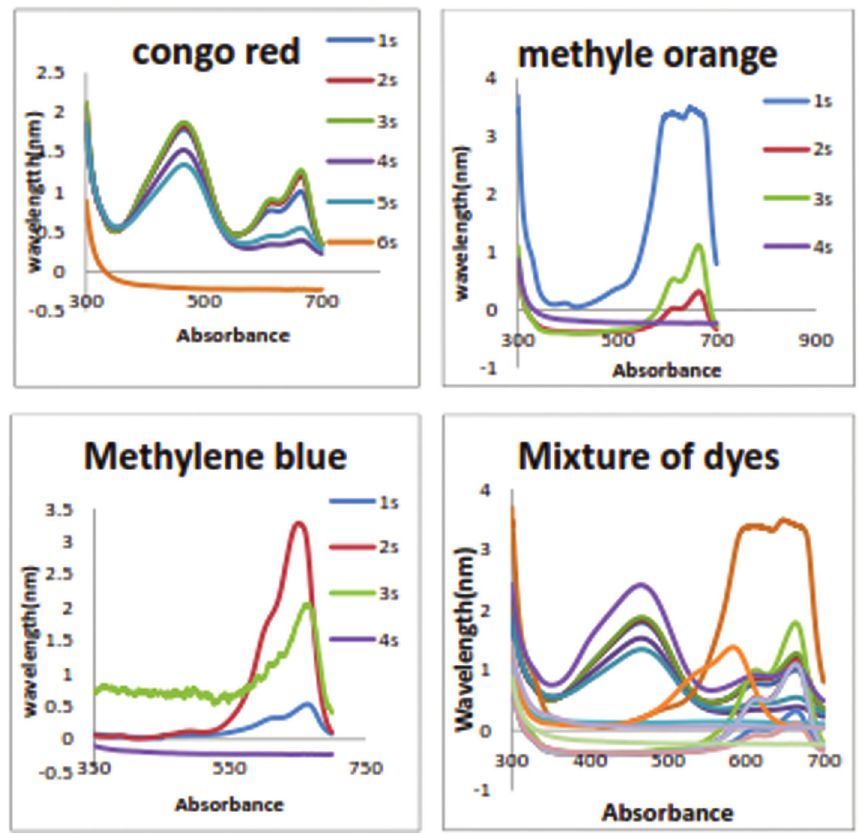
Figure 14: Catalytic activity of PdNPs in degradation of Congo red, methyl orange, methylene blue and mixture of the four different